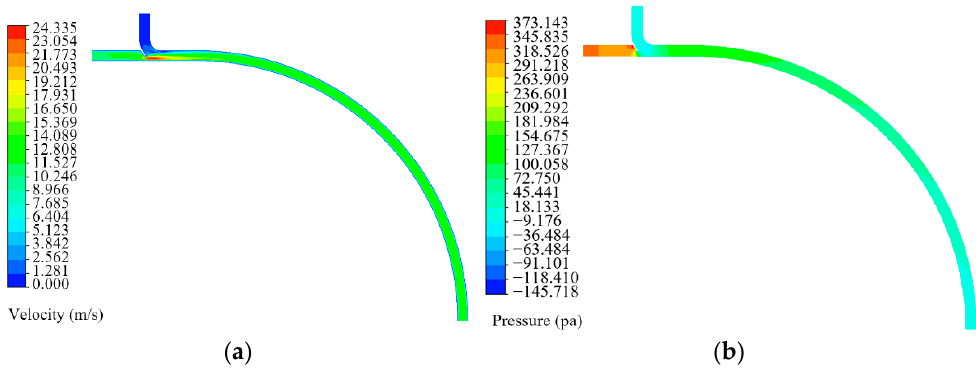
Figure 7. Simulation of the flow field of the seed delivery pipe. ( a ) Velocity distribution cloud; ( b ) Pressure distribution cloud.